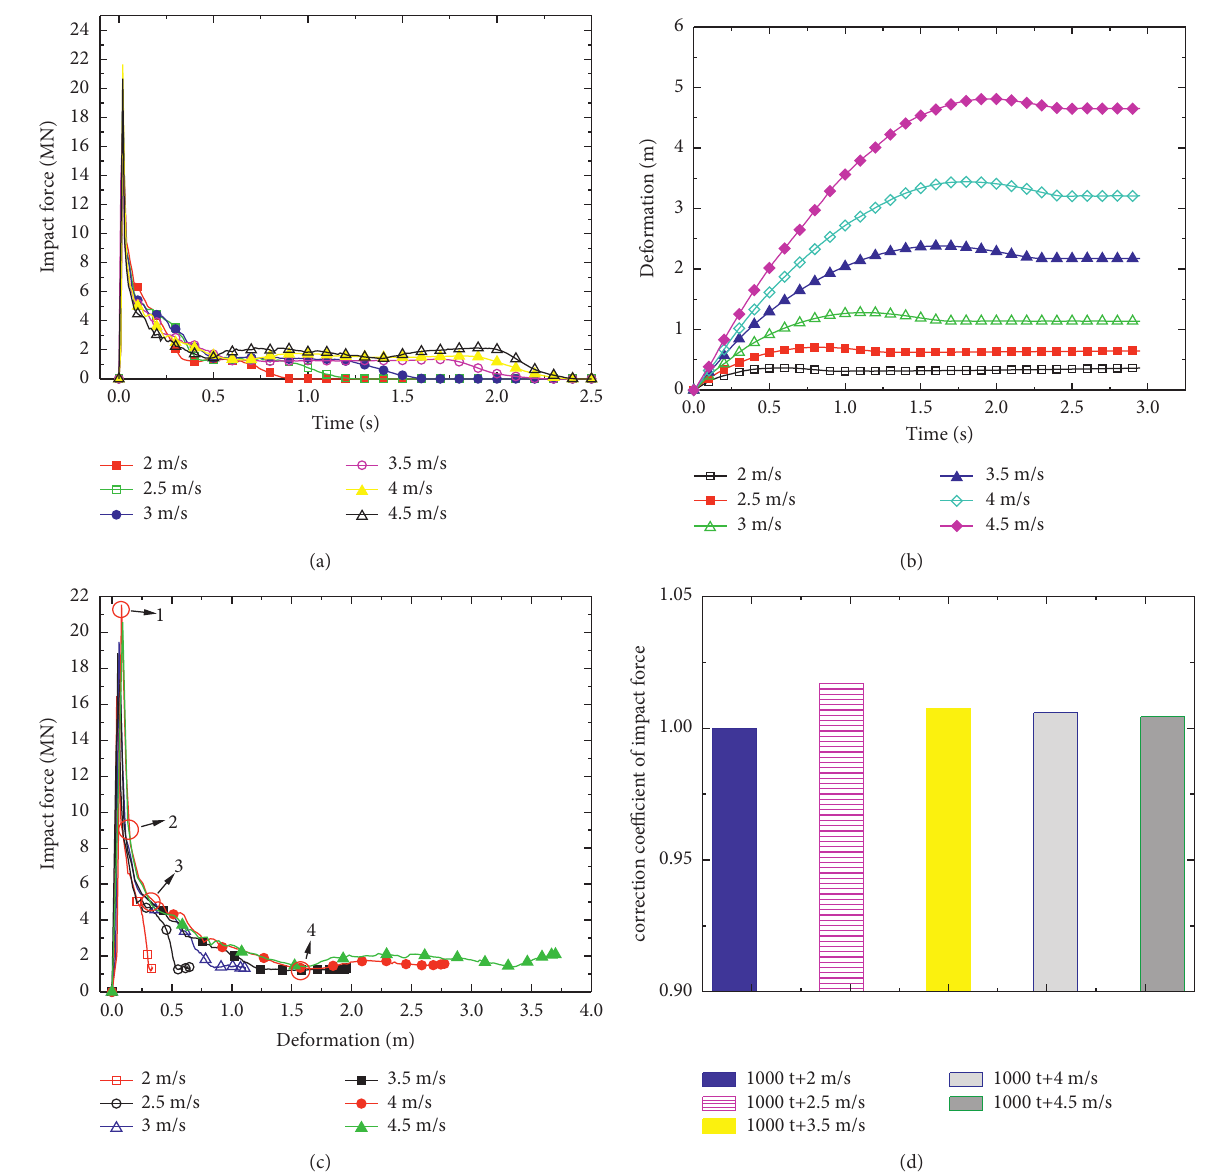
Figure 5: Simulation results vary with the impact velocity of barge impact on rigid wall. (a) Impact force varies with impact velocity. (b) Bow deformation varies with impact velocity. (c) NSS varies with impact velocity. (d) Correction coefficient of impact